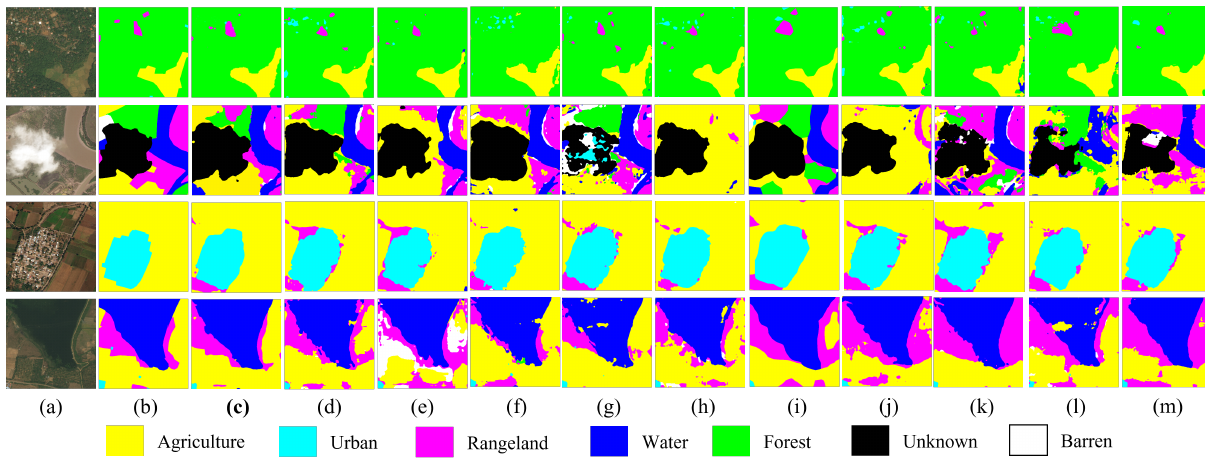
Figure 7. Comparison of different state-of-the-art models segmentation results on the DeepGlobe dataset: ( a ) Raw image, ( b ) Ground truth, ( c ) DEANet(Ours) , ( d ) GCNet, ( e ) PSPNet, ( f ) UNet, ( g ) DeepLabv3, ( h ) DeepLabV3+, ( i ) EncNet, ( j ) PSANet,